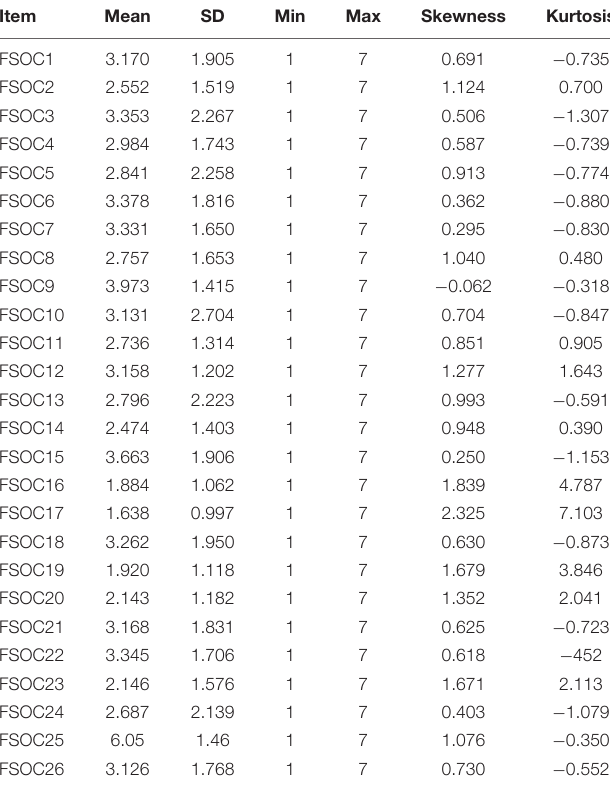
TABLE 2 | Descriptive and distributional properties of items of family sense of coherence